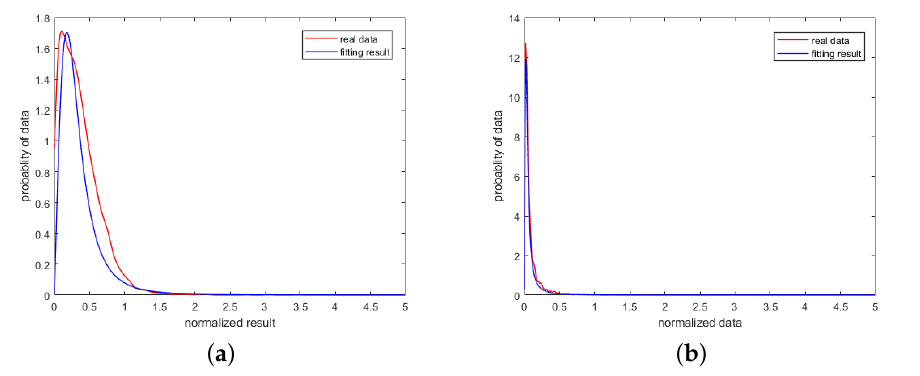
Figure 8. Statistical Fitting Results: ( a ) Data curve and fitting curve of warehouse at 1st angle; ( b ) Data curve and fitting curve of tank at the 100th